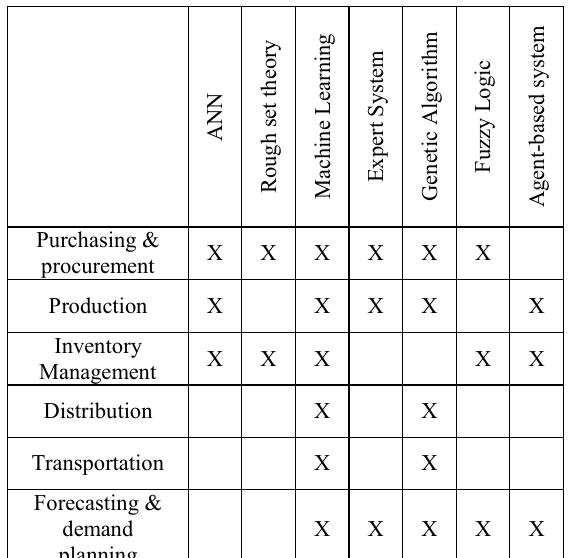
Table 1. Sub-field AI Application’s in the